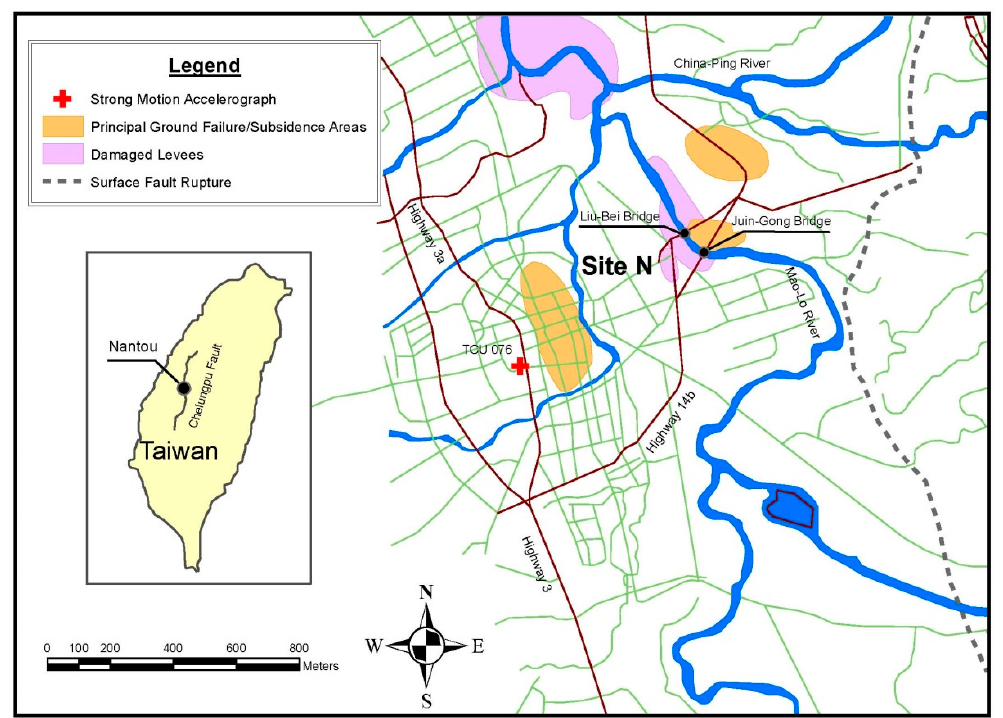
Figure 2. Location of lateral displacement and ground failure due to liquefaction during the Chi-Chi earthquake in the Nantou district.